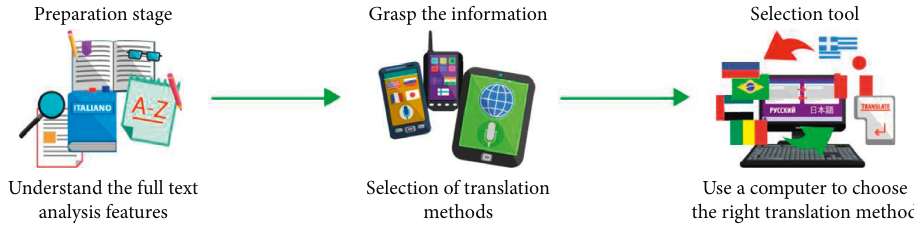
Figure 1: Machine translation system based on semantic language. Table 1: Left and right adjacency structures in procedure files. Order number Gram The word length of the Gram